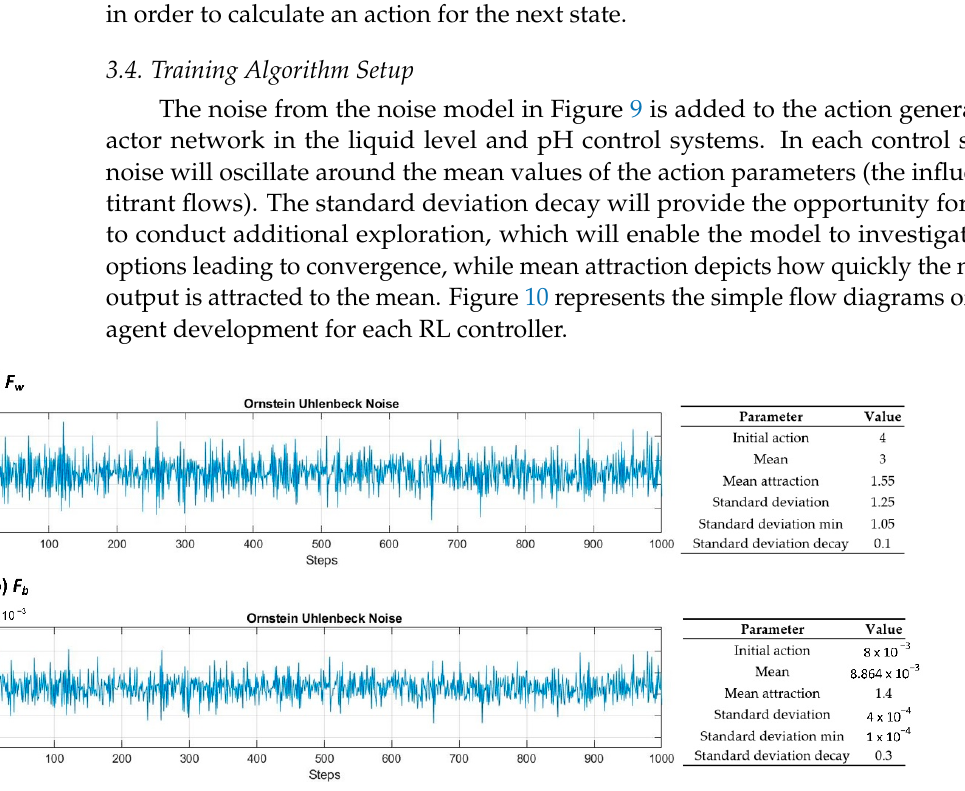
Figure 9. Action noise models of the DDPG agents: ( a ) influent feed ( F w ) and ( b ) titrant feed ( F b ).